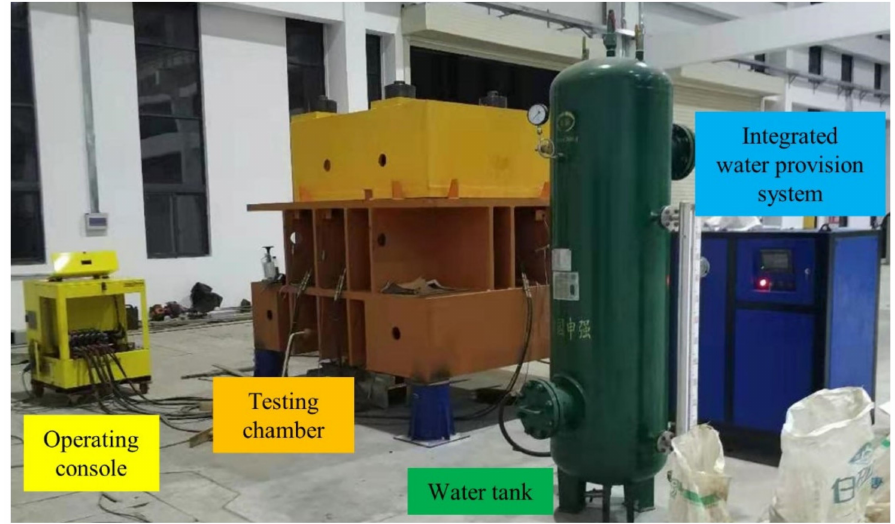
Figure 3. Photograph of the improved large-scale stress-controlled apparatus.